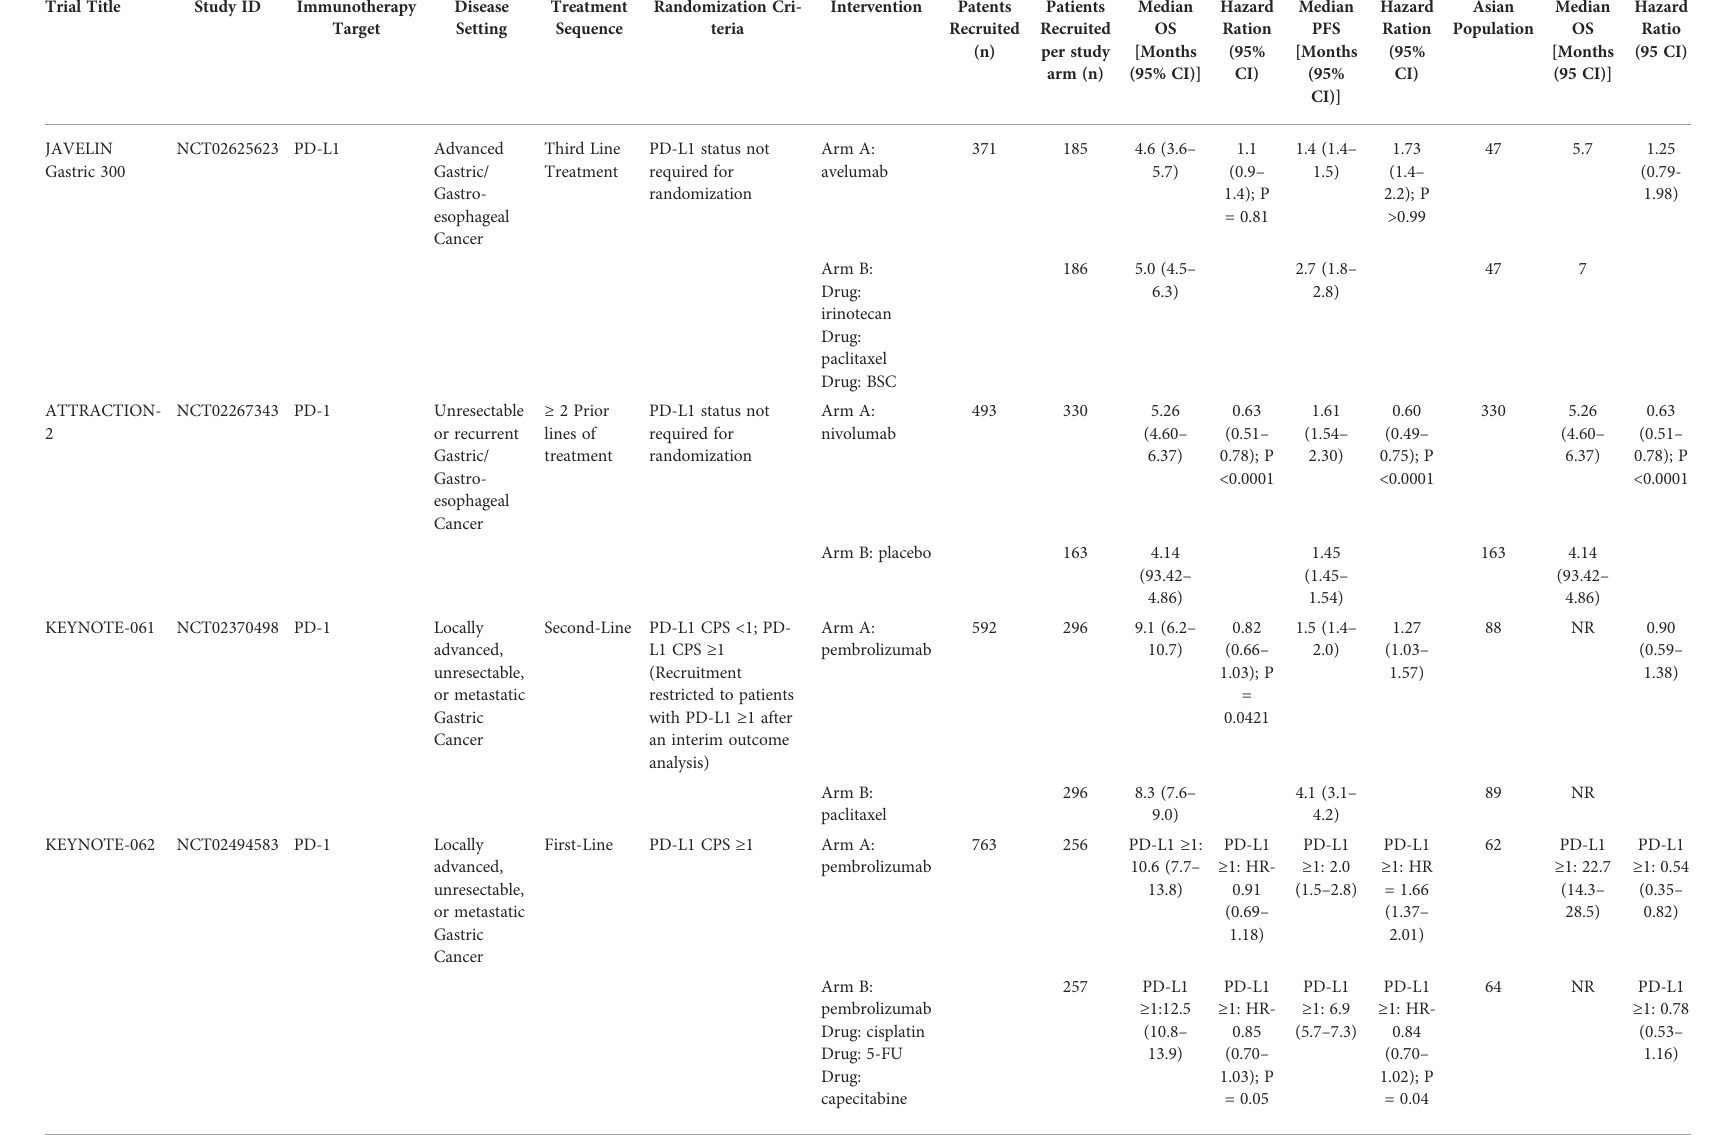
TABLE 1 Characteristics of randomized controlled trials. In the